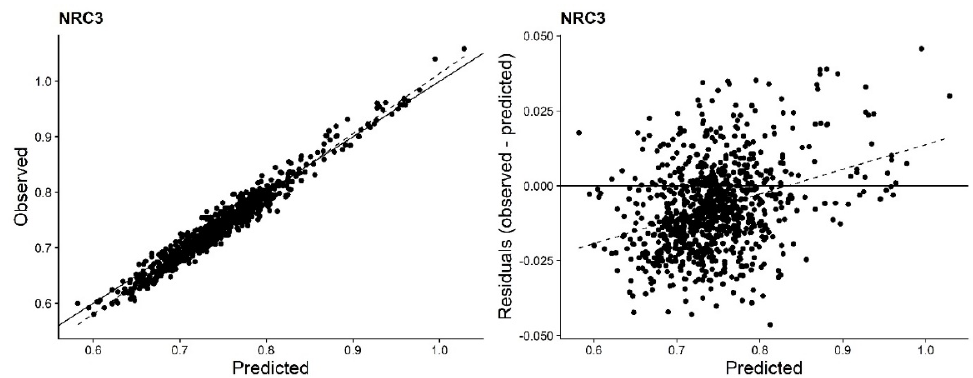
Figure 3. Plots of observed versus predicted milk energy (Mcal/L) and observed minus predicted (residual) versus predicted milk energy (Mcal/L) using Tier 3 equations. The dotted lines represent the regression lines. CNCPS, Cornell Net Carbohydrate and Protein System; CSIRO, Commomwealth Scientific and Industrial Research Organization; Jap, Japan; NRC, National Research Council.